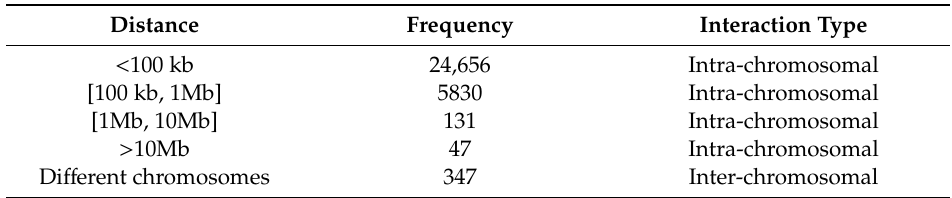
Table 3. Span distribution of